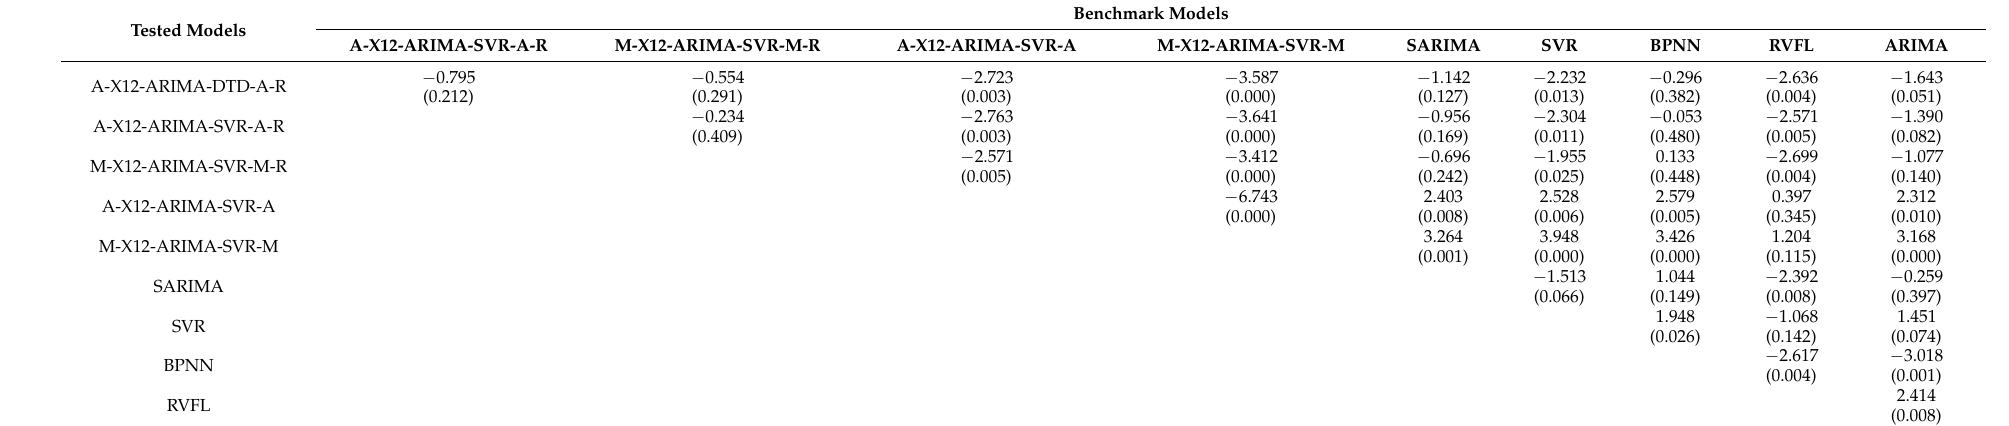
Table 15. DM test results across different models for gasoline consumption data in Qinghai.